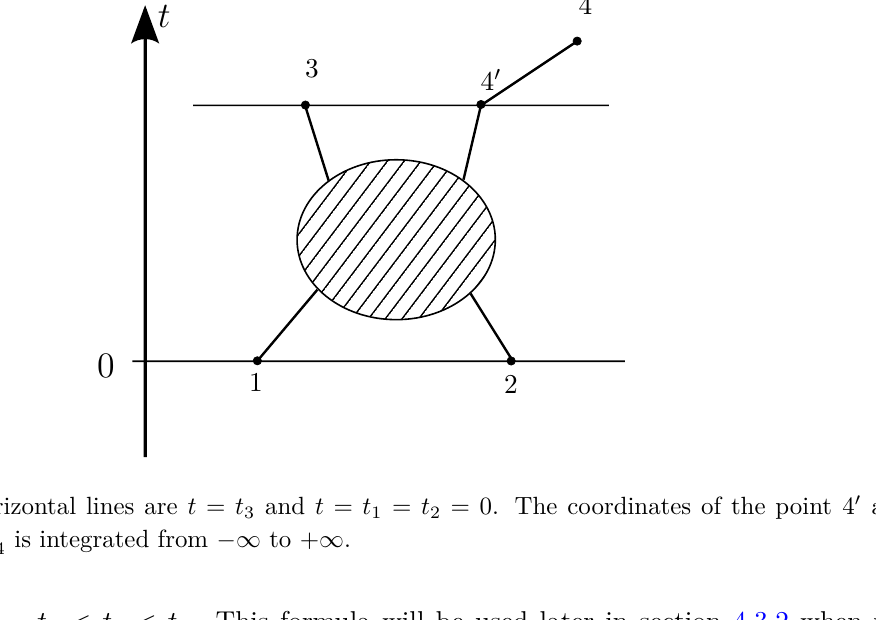
and x 0 are to be integrated from −∞ to + ∞ . 1 4